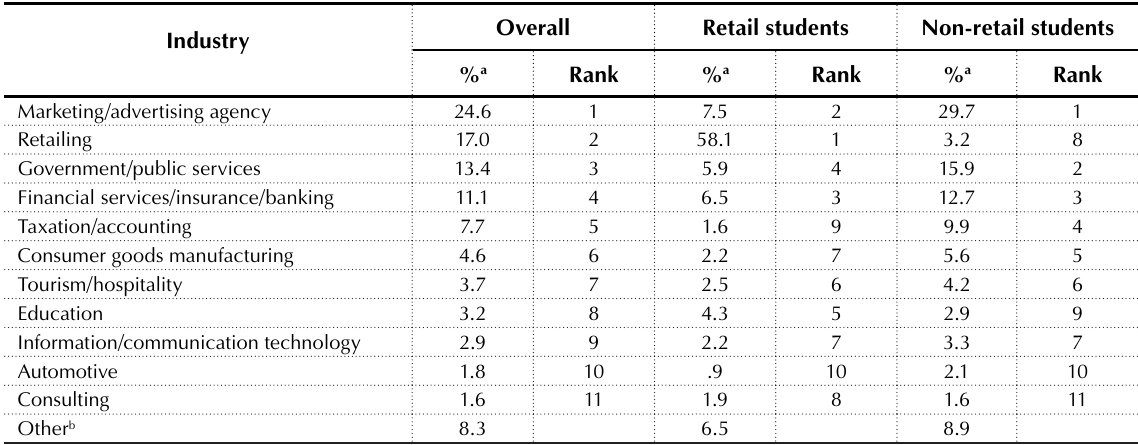
Table 6. Studentsʼ preferred industry after